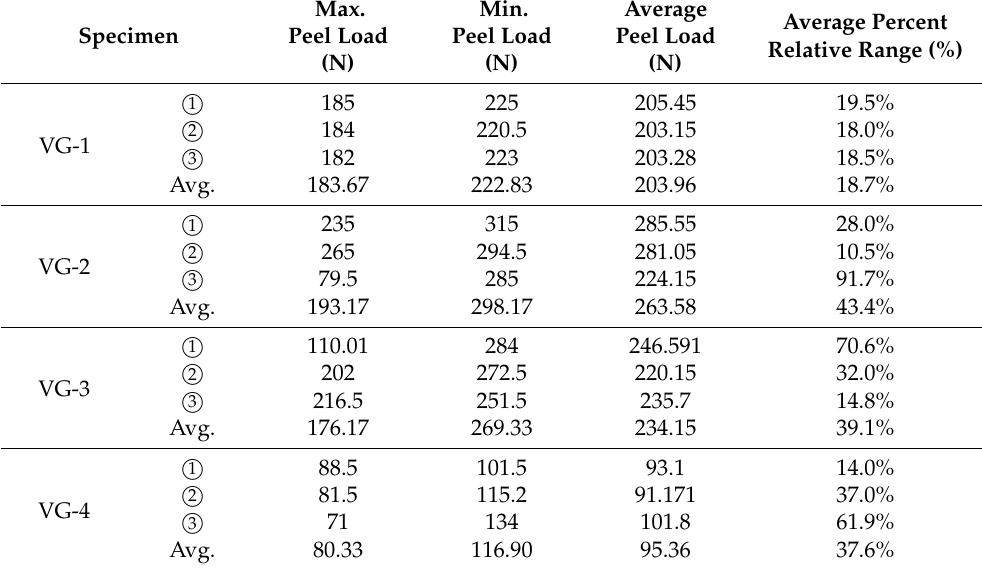
Table 11. The percent relative range calculation